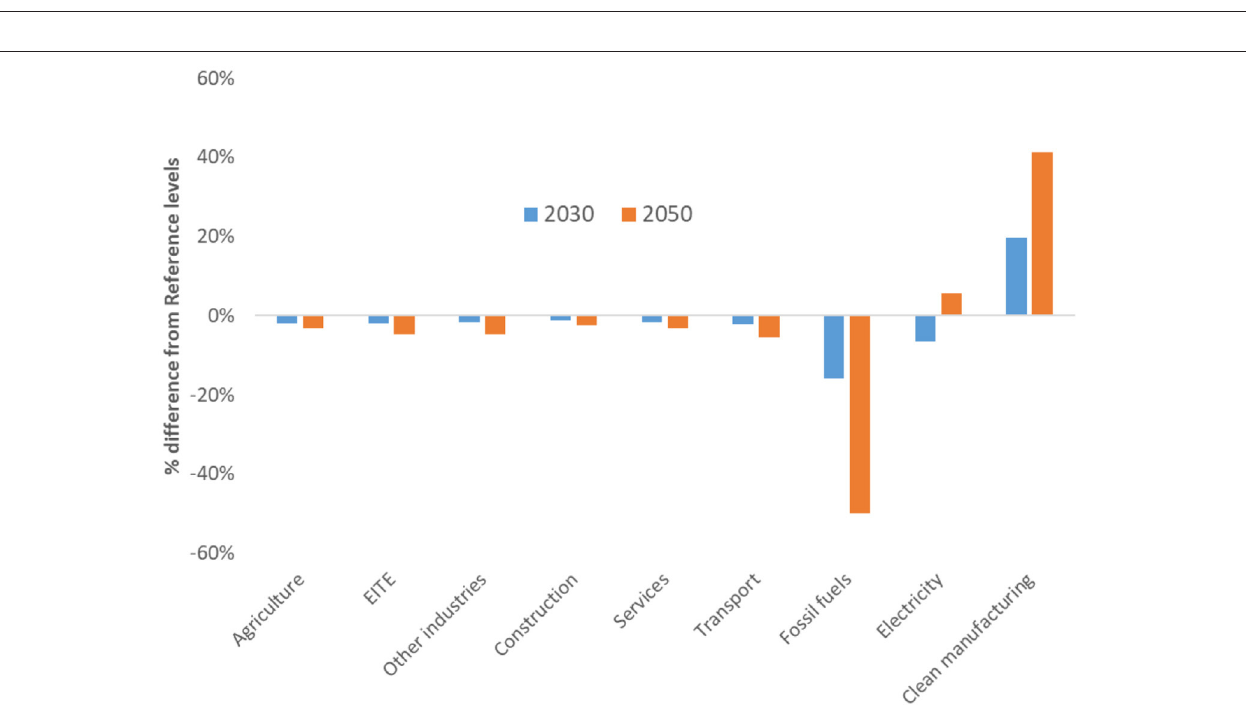
FIGURE 15 | Impacts of 2DEG scenario on global employment by main sector.